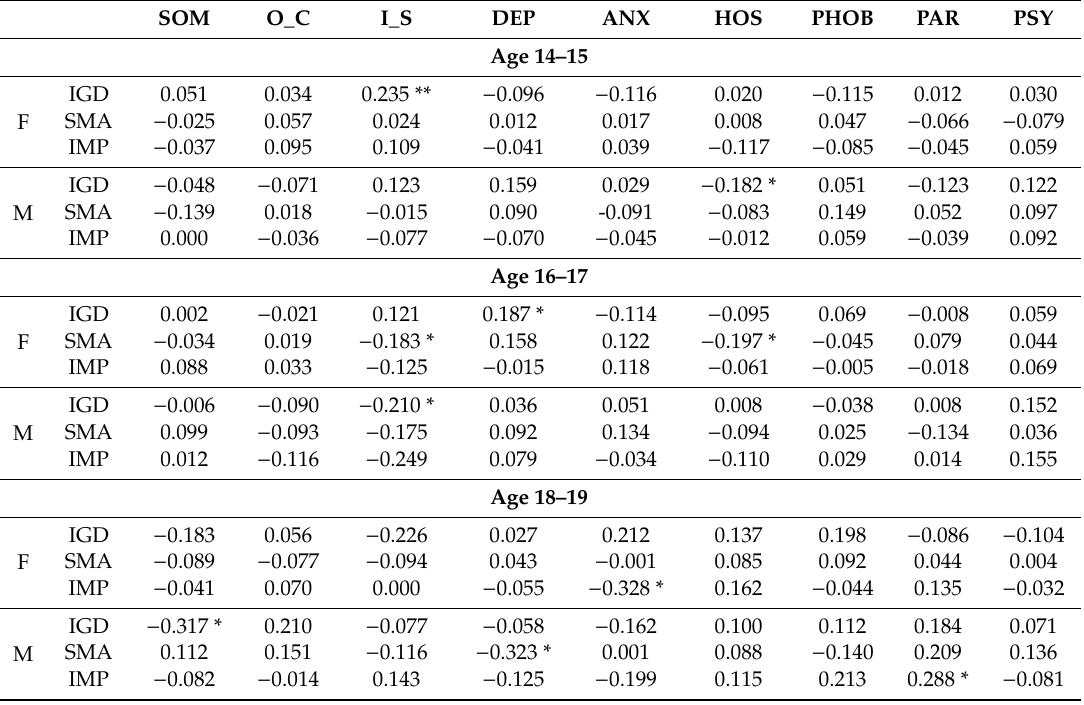
Table 7. Partial correlations between the variables of interest for gender per age